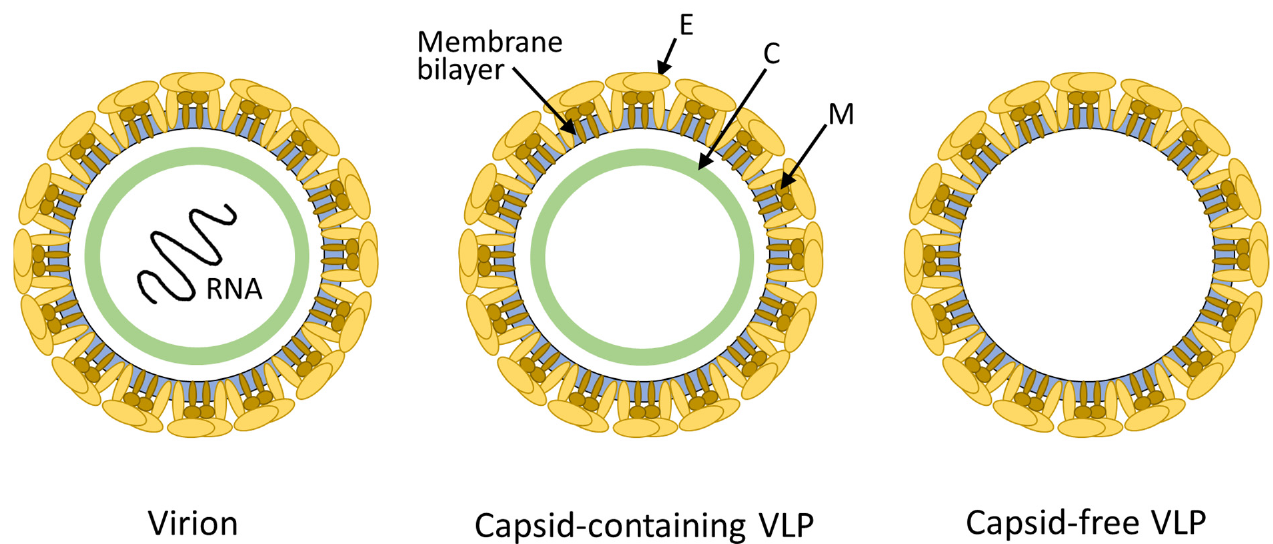
Figure 1. Schematic diagrams of mature flaviviruses or mature virus-like particles (VLPs): infectious virus (virion), capsid-containing VLP and capsid-free VLP. The positive-sense RNA found in virions is shown in black. The capsid (C) protein is represented in green, the envelope (E) protein in orange, the membrane (M) protein in brown, and the lipid membrane bilayer in